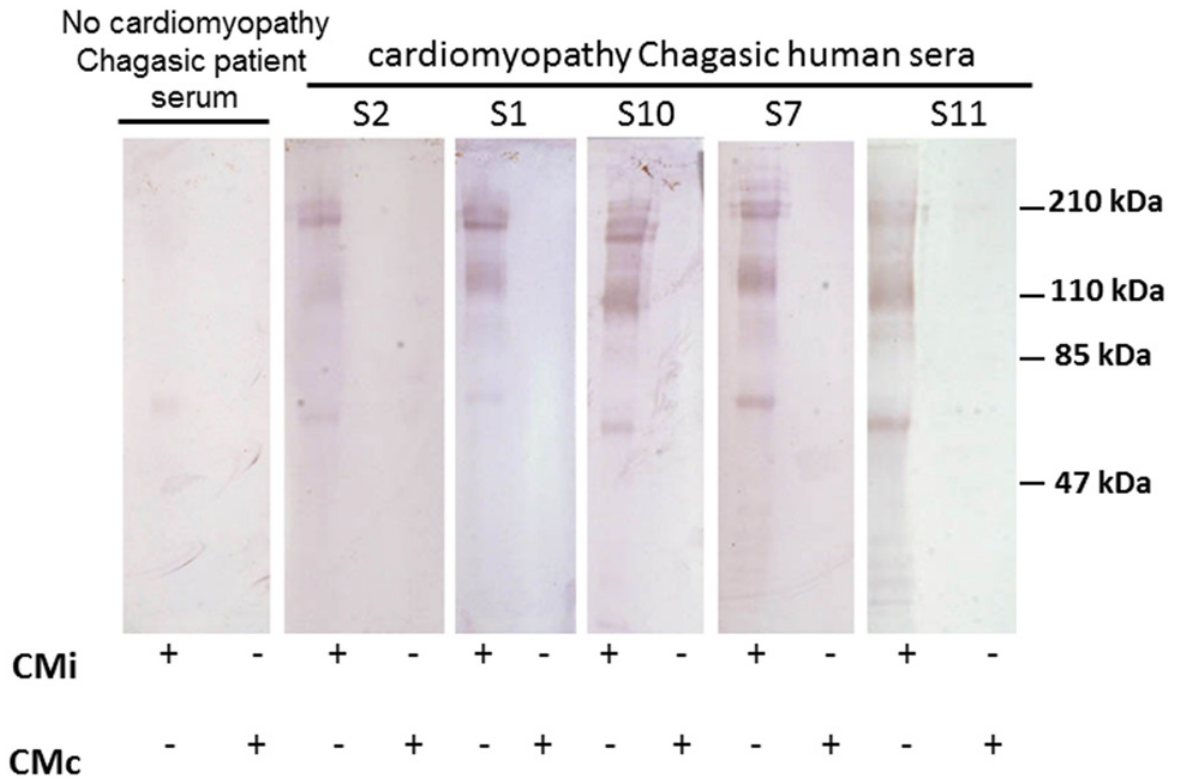
Fig 6. Western blotting analysis of conditioned medium. Protein fraction > 50 Kda obtained from CMi and CMc were resolved by gel electrophoresis and probed with sera samples (dilution 1:100) from seropositive class II chagasic patients that exhibited moderate symptoms of clinical disease. As controls it was assayed a no cardiomyopathy Chagasic patient